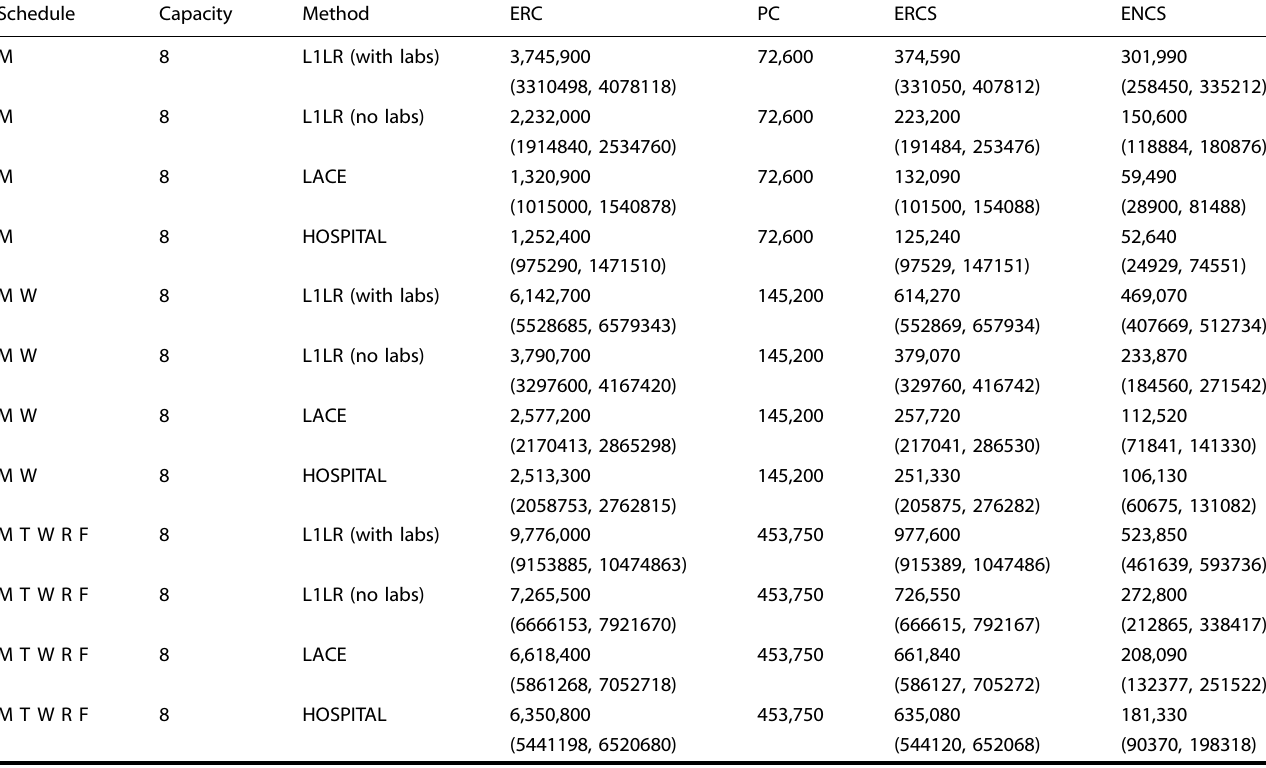
Table 3. Simulation-based cost performance metrics for the four different models. Schedule